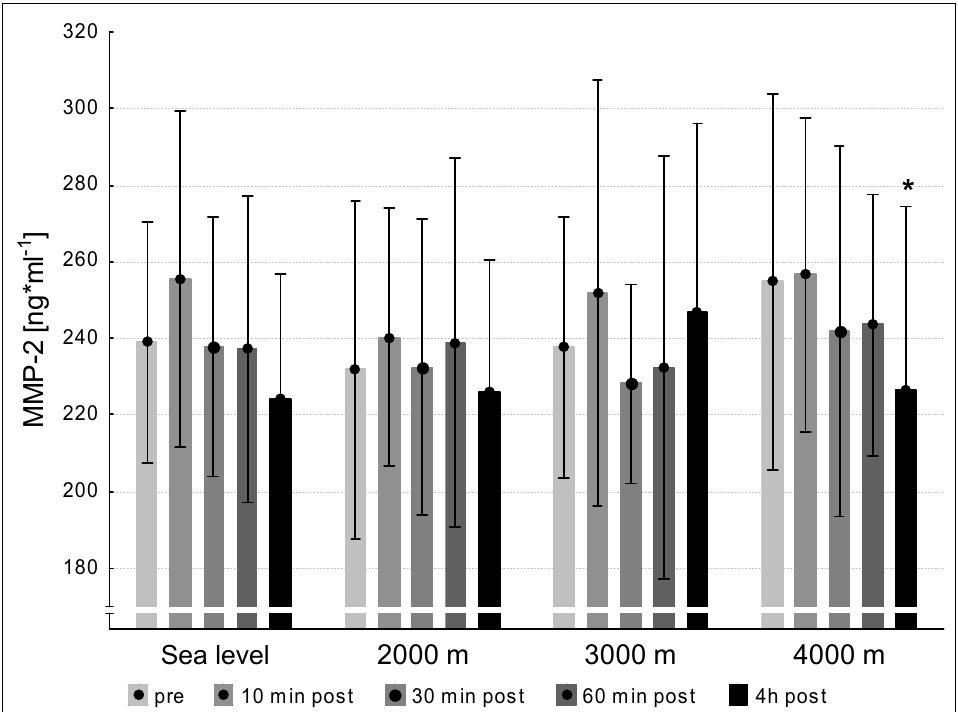
Figure 3. MMP-2 concentration at the five measurement time points (pre, 10 min post, 30 min post, 60 min post, 240 min post exercise) during the different ambient conditions (sea level, 2000 m, 3000 m, 4000 m). Mean ± standard deviation. * p < 0.05 to pre. Medicina 2021 , 57 , x FOR PEER REVIEW